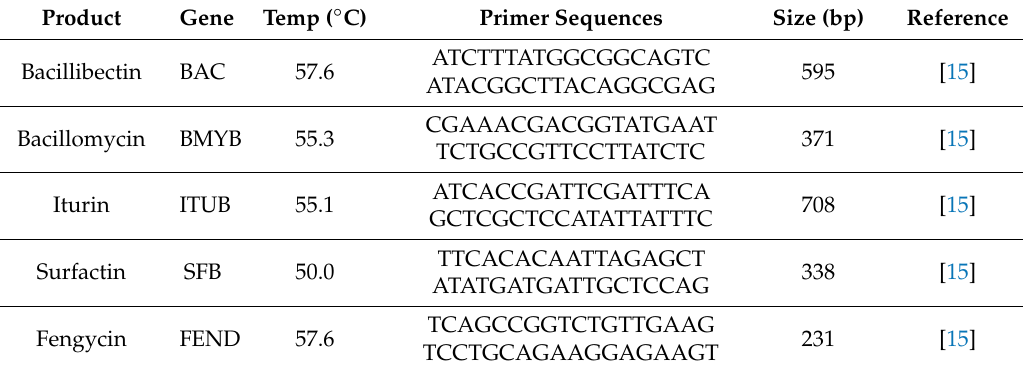
Table 2. Genetic markers used for the detection of antifungal genes in genomes of the isolates.